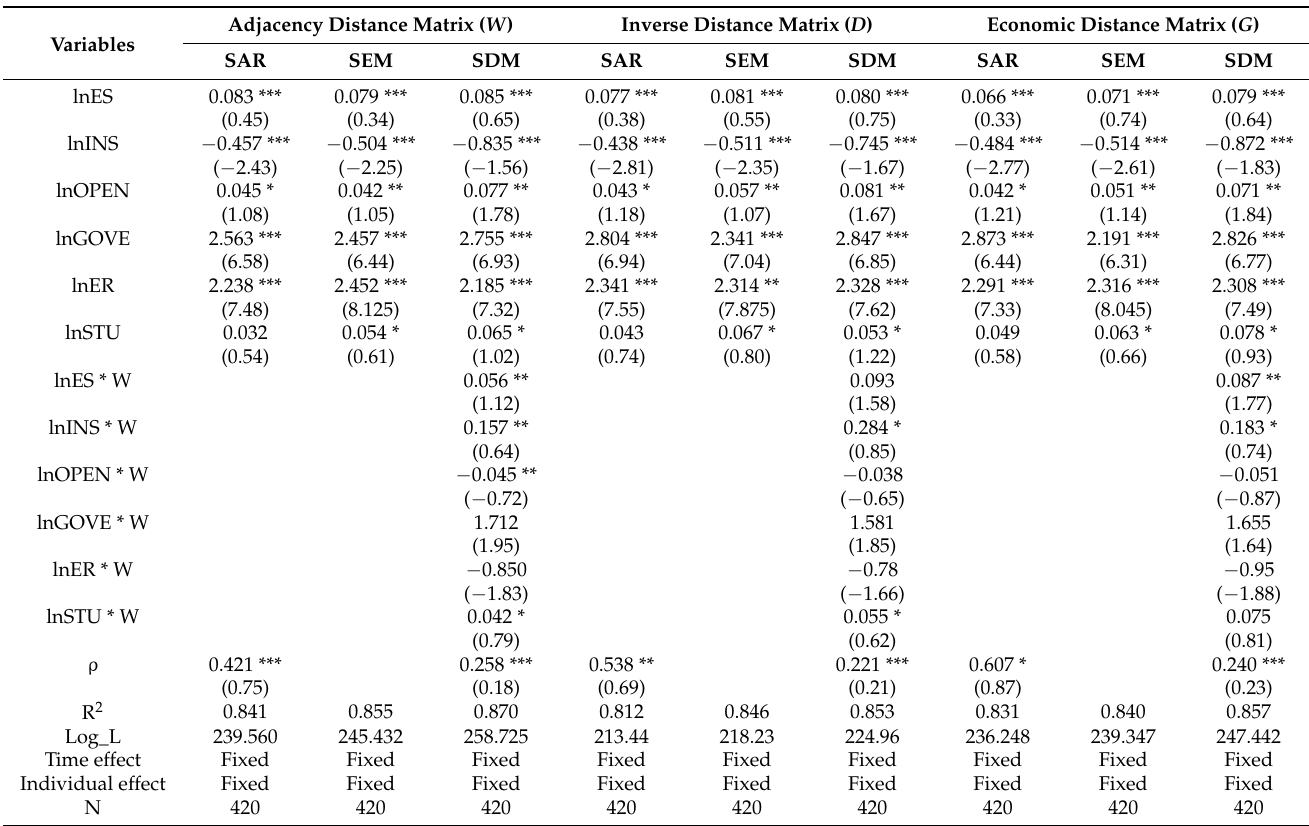
Table 3. National spatial econometric regression